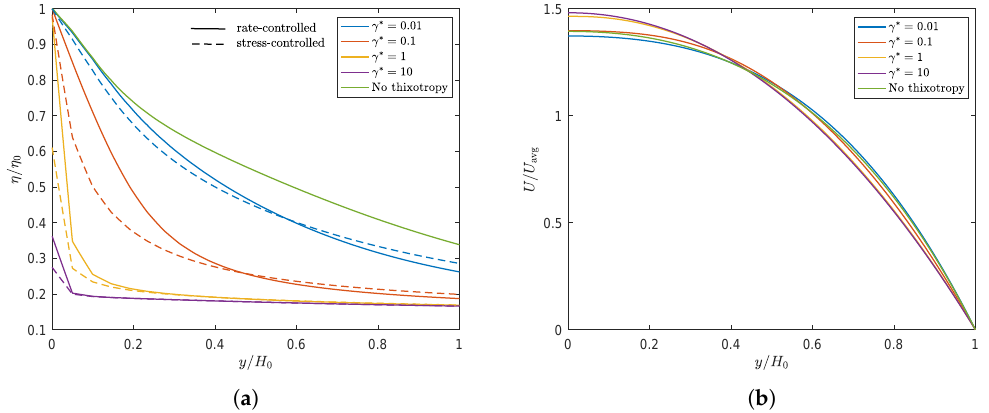
Figure 12. Ratio of the total viscosity and the zero-shear viscosity over the die height at Γ in for λ θ = 10 λ avg and different damage parameters for the rate and stress-controlled approaches ( a ). Dimensionless velocity magnitude over the die height at Γ in for λ θ = 10 λ avg and different damage parameters for the rate-controlled approach ( b ). ( a ) λ θ = 10 λ avg . ( b ) λ θ = 10 λ avg .